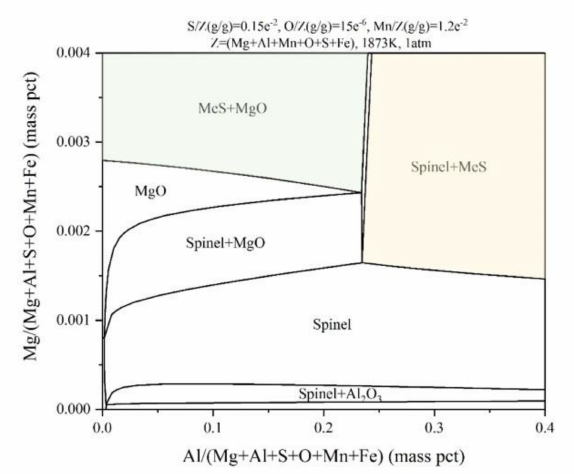
Figure 6. Stability diagram for Fe-Mg-Al-Mn-O-S system at 1600 ◦ C (MeS: Mg 0.9 Mn 0.1 S, Spinel: MgAl 2 O 4